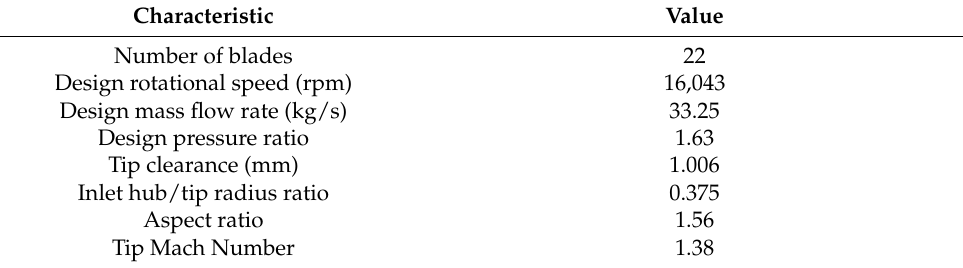
Figure 1. Schematic of the computational domain and inlet pressure distortion profile. Table 1. NASA Rotor 67 main characteristic parameters at the design point.